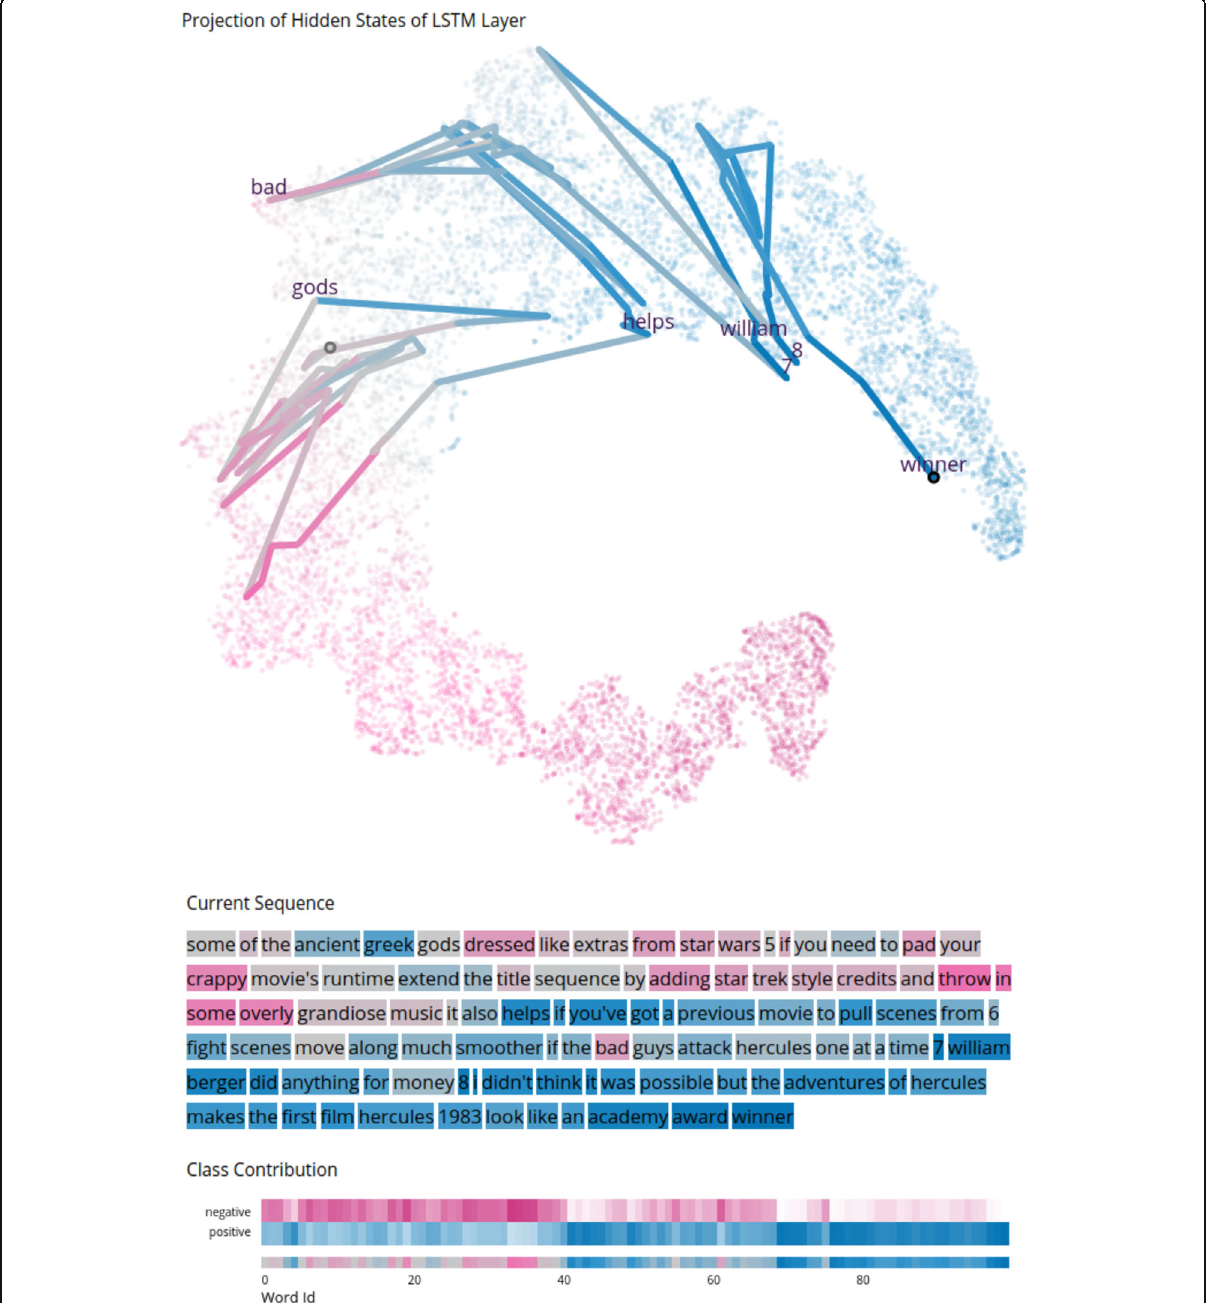
Fig. 5 Example of a wrongly classified sequence from the IMDB dataset. For the first part of the sequence, the classification is rather negative (pink). Only in the second half of the sequence does the classification become positive (blue). The last words in particular contribute to the incorrect classification, where the name of an actor appears, and afterward, the words refer to another film that was rated better compared to the current one. Underlying data source: IMDB as available in Keras